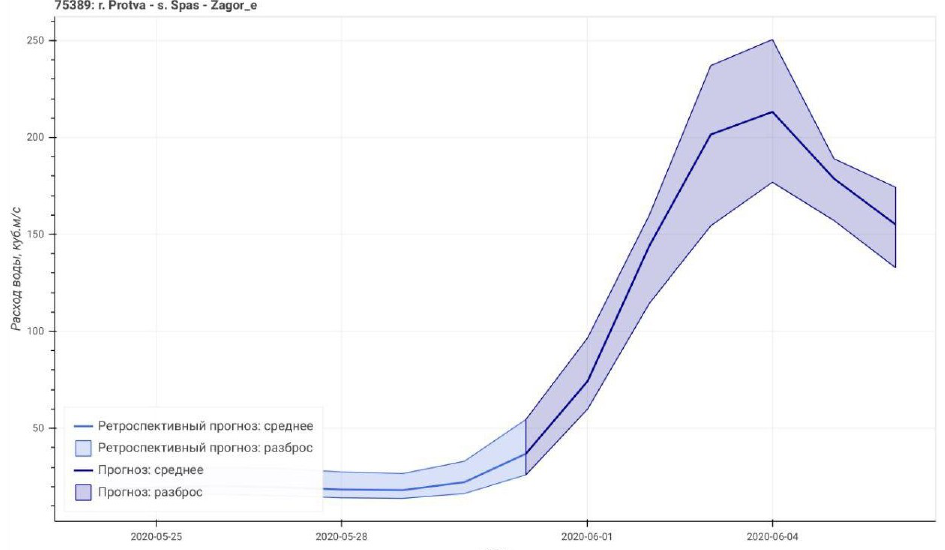
Figure 3. Example of the issued forecast for the Protva River at Spas-Zagor’e. Transcription from Russian as follows. x -axis: date; y -axis: discharge, m 3 /s. The legend shows the following: bold light blue line: hindcast mean; light blue area: hindcast spread; bold blue line: forecast mean; blue area: forecast